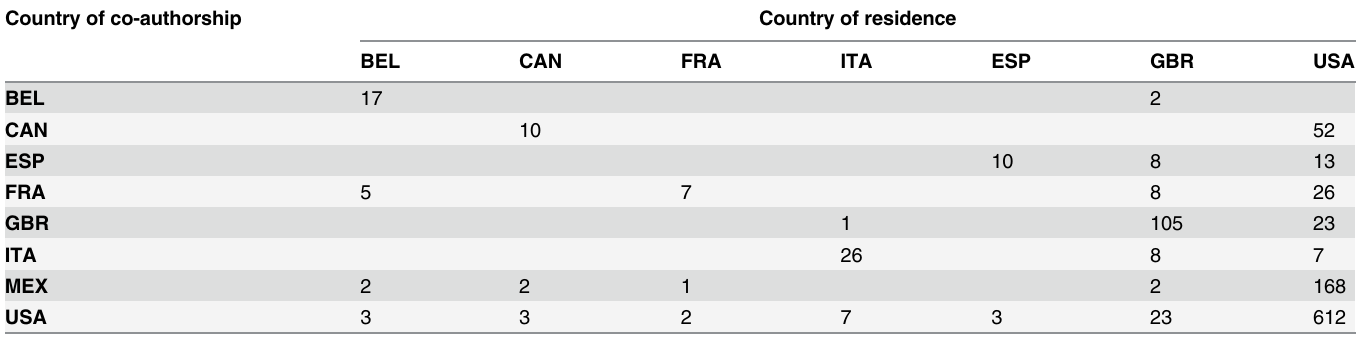
Table 5. Distribution of co-authorships for the 2104 papers published by the scientific Mexican Diaspora in the biological sciences by country of residence vs. countries of co-authorship (2000 – 2013). Country of